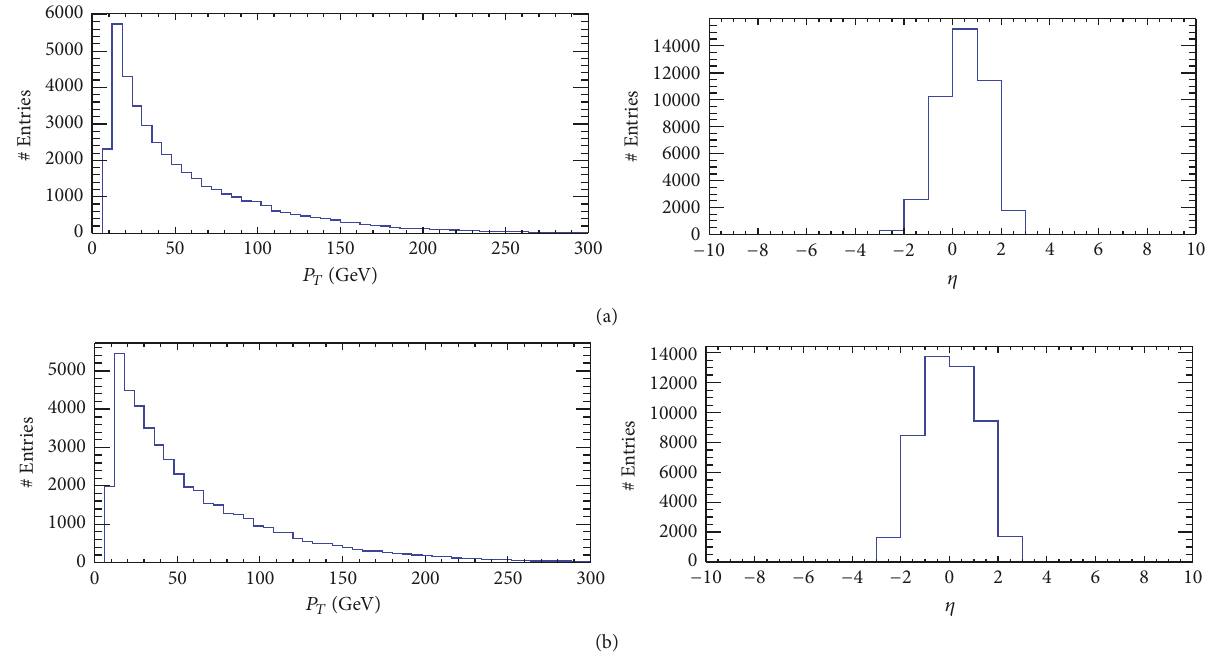
Figure 6: Transverse momentum and pseudo-rapidity distribution of electron from the process 𝑒 − 𝑝 → 𝑒 − 𝑊 ± 𝑞 + 𝑋 for background ( 𝐵1 ) (a) and the process 𝑒 − 𝑝 → 𝑒 − 𝑍𝑞 + 𝑋 for background ( 𝐵2 ) (b) at the LHeC.